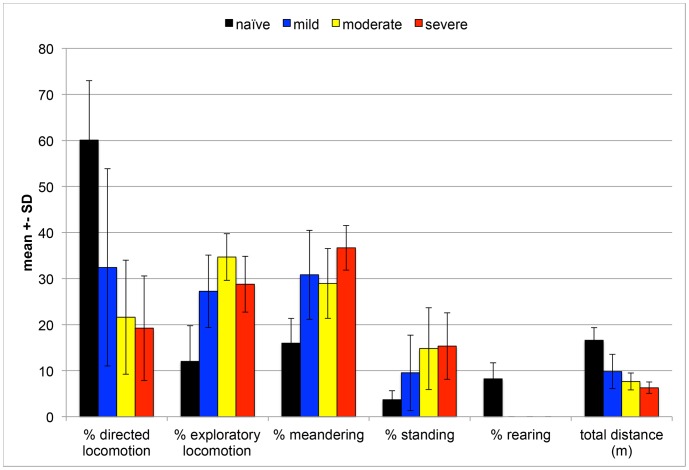
Percentage of trial each group spent performing classified behaviors and total distance covered.Mean and standard deviation of the percentage of the two-minute trial spent performing each movement and the total distance moved during the trial. Naïve animals spent the largest percentage of the trial in directed locomotion, and the least standing.